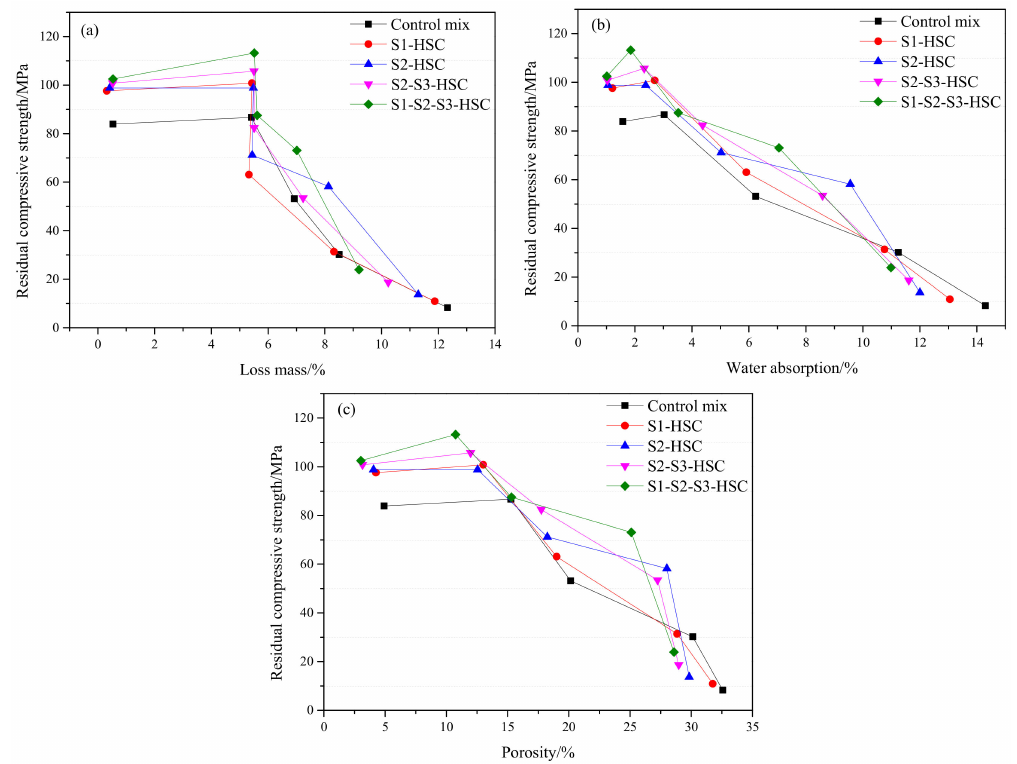
Figure 12. Relation between residual compressive strength and physical properties: the relation between residual strength and ( a ) loss mass, ( b ) water absorption, and ( c )